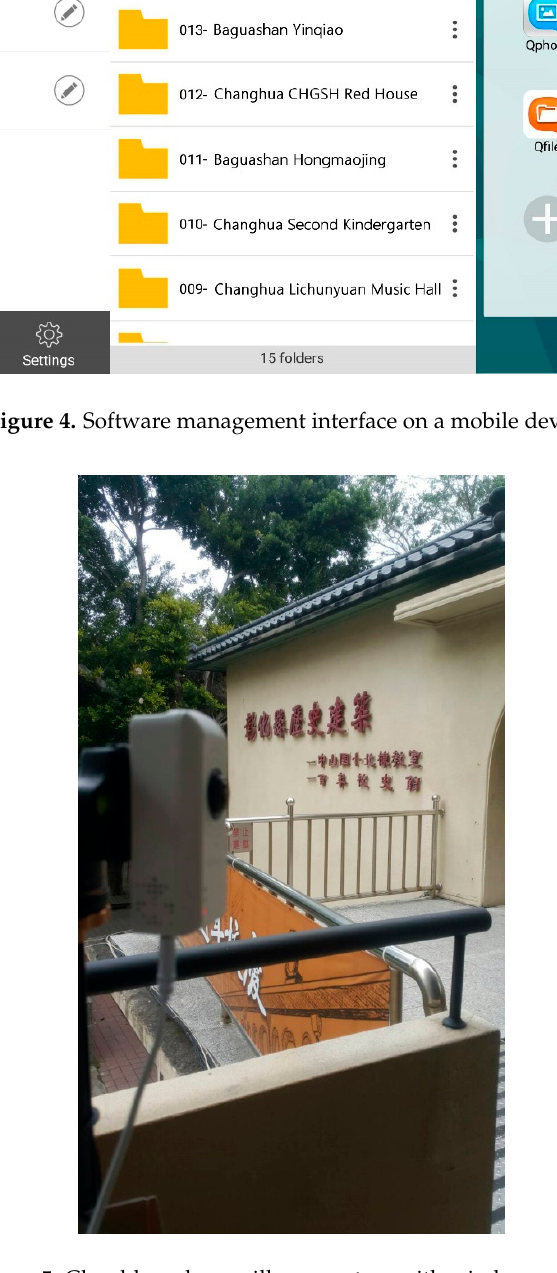
Figure 6. Monitoring interface on mobile devices (warnings and notifications).